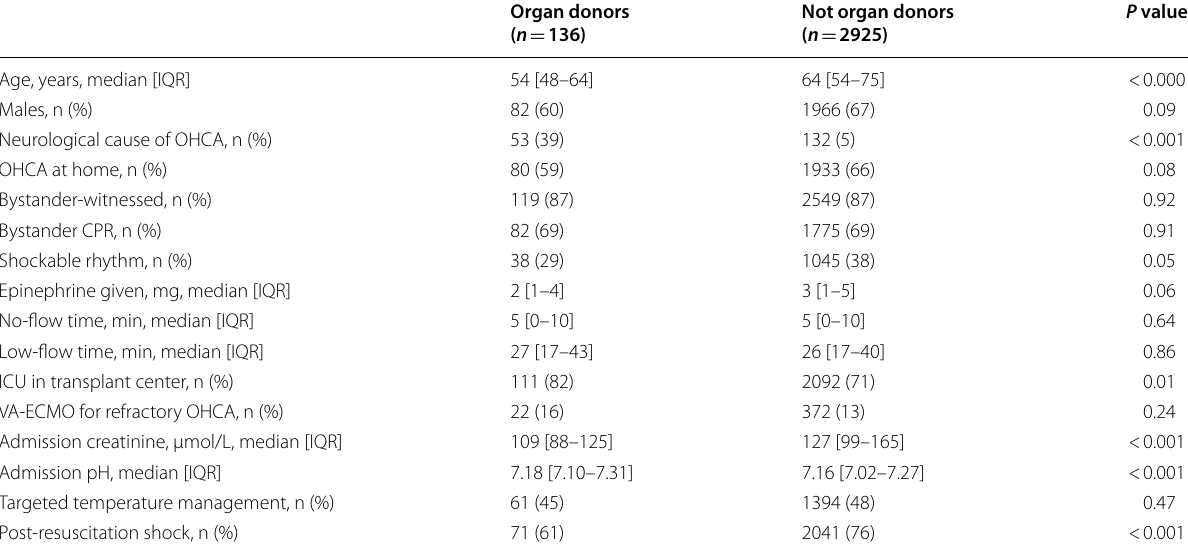
Table 1 Utstein characteristics of patients with out-of-hospital cardiac